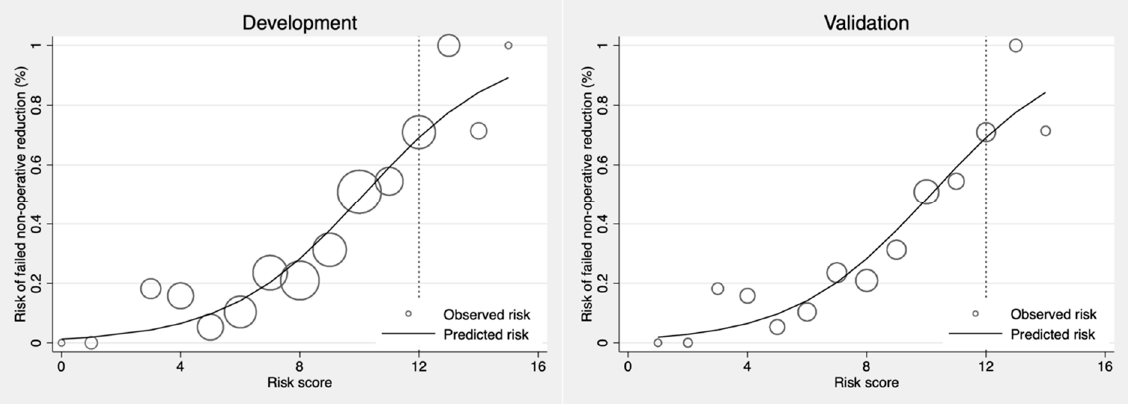
Figure 5. Calibration plots of the CMUI score in the development and validation sets. The dash lines at the cutoff point of 12 categorized patients with intussusception into low ‐ risk and high ‐ risk groups of failed non ‐ operative reduction.